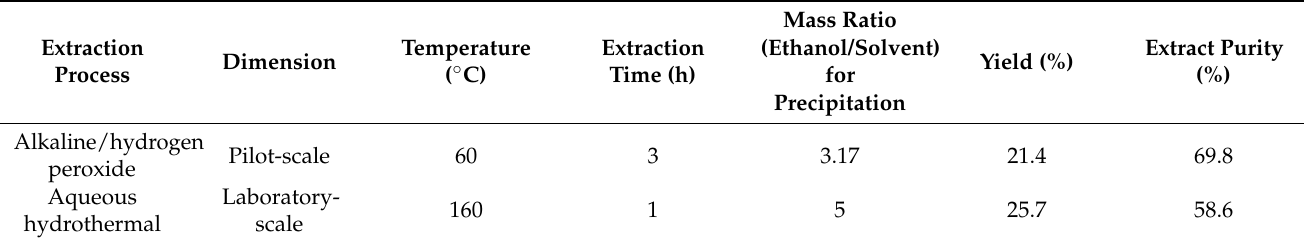
Table 4. Comparison of alkaline/oxidative and aqueous/hydrothermal extraction procedures for wheat bran arabinoxylans.